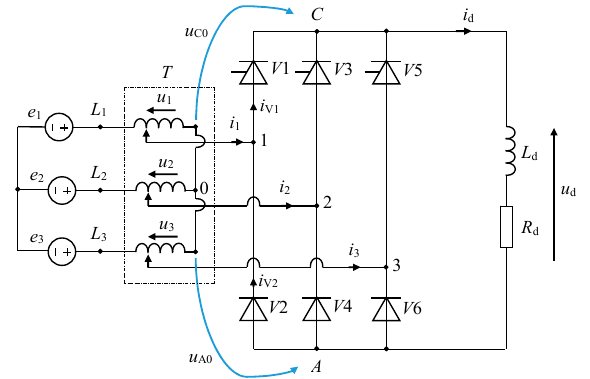
Figure 4. Schematic of a three-phase semiconverter with resistive–inductive load; 0 is the neutral point; C is the cathode group of thyristors V 1, V 3, and V 5; and A is the anode group of diodes V 2, V 4, and V 6.